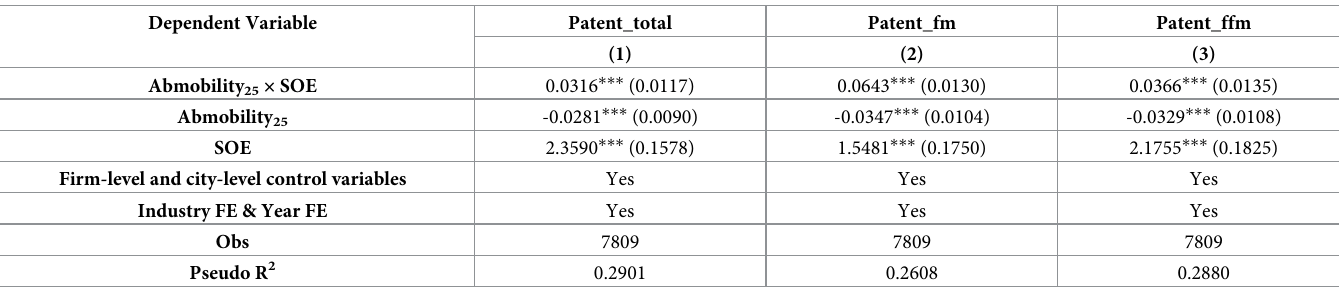
Table 10. Heterogeneity test of firm